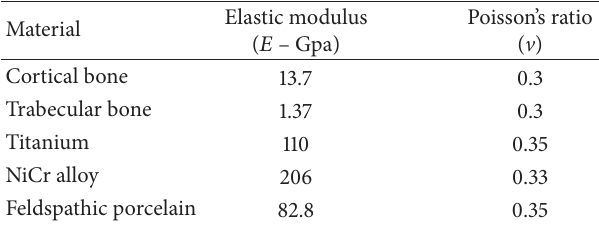
Table 1: Description of models developed for this study. Implant